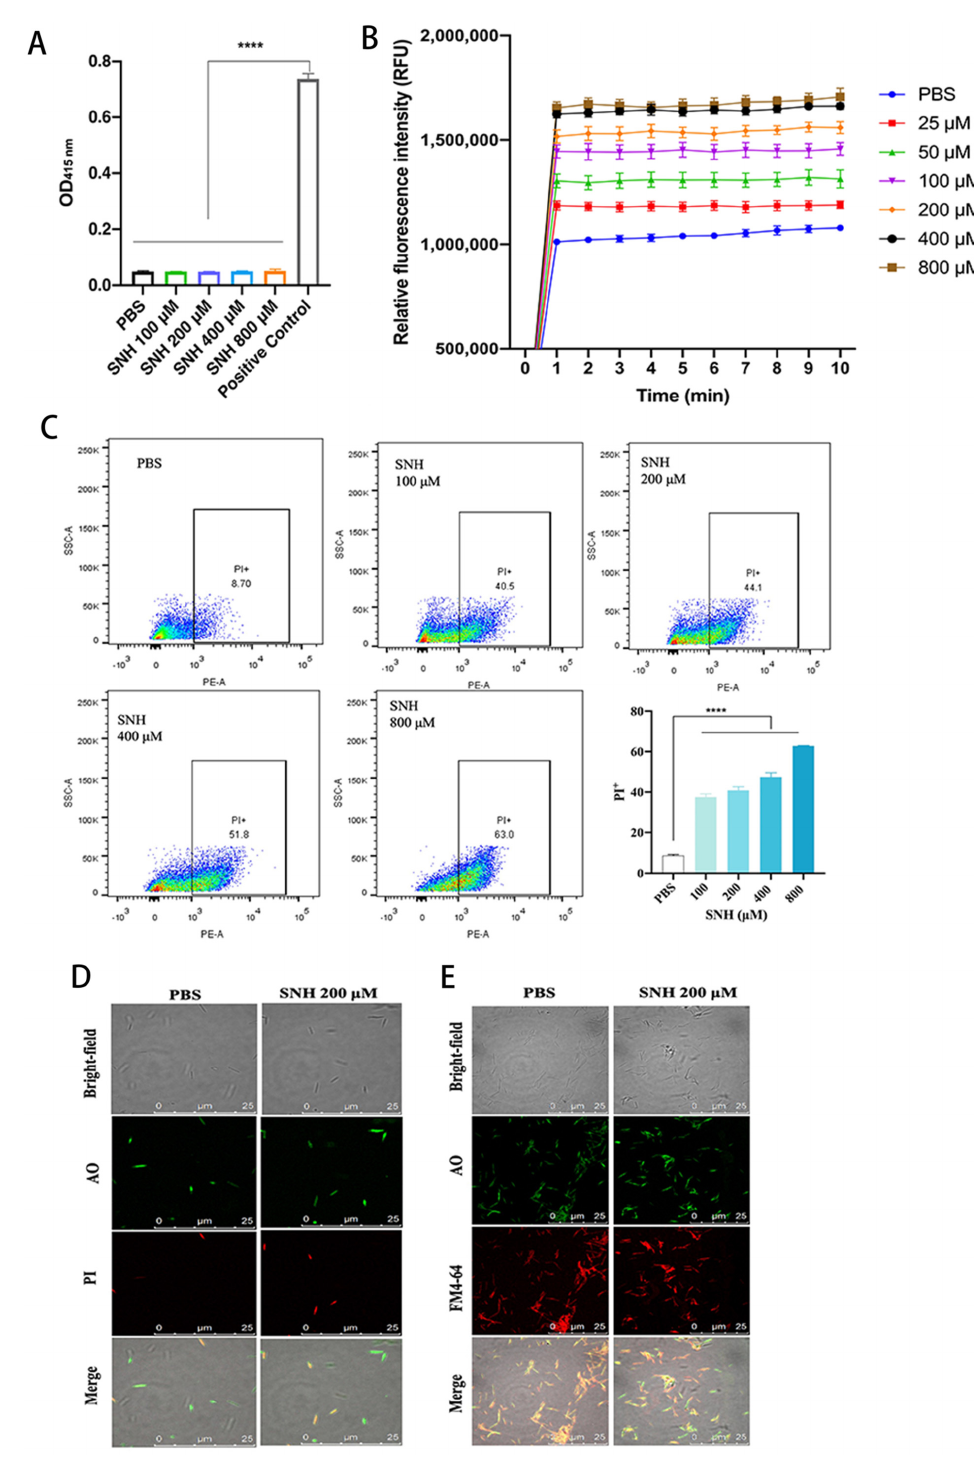
Figure 1. The effects of SNH on the level of reactive oxygen species and membrane integrity of Fn . ( A ) The effect of SNH on the intracellular hydrogen peroxide levels in Fn. ( B ) Dose–dependent outer membrane permeabilization of Fn induced by SNH. Time course of fluorescence of NPN bound to inner phospholipid membrane of Fn induced by different concentrations of SNH. PBS was used as a negative control. The experiment was performed independently three times. ( C )